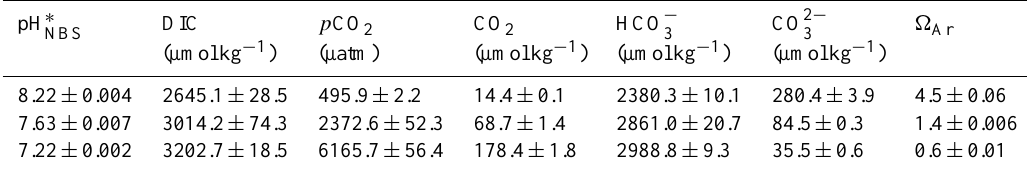
Table 1. Summary of chemical parameters in control and acidic seawater ( n = 3).